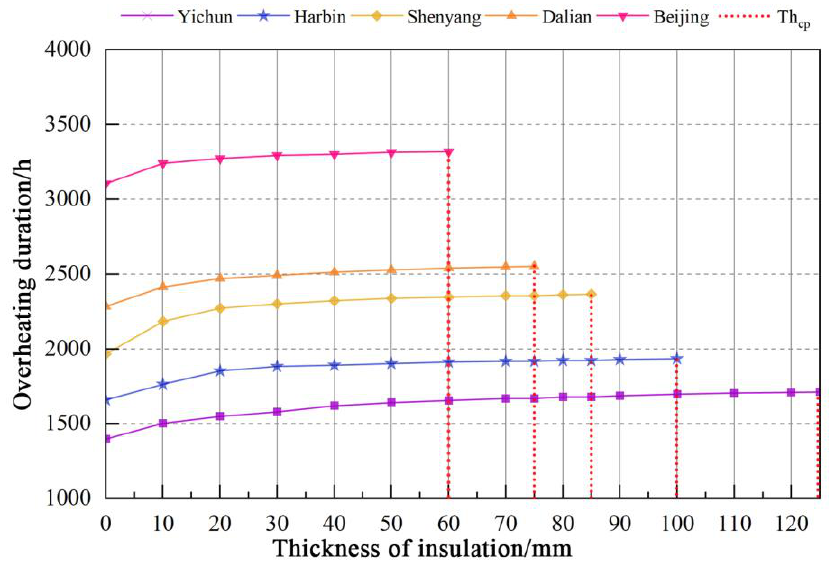
Figure 8. Overheating duration of unoccupied south-facing bedrooms constructed with increased Th insulation in the five cities during the summertime over 15 years (2004 to 2018) (the red dotted lines show the overheating hours of the flats constructed with Th cp , i.e., the current standard values of thermal insulation thickness).